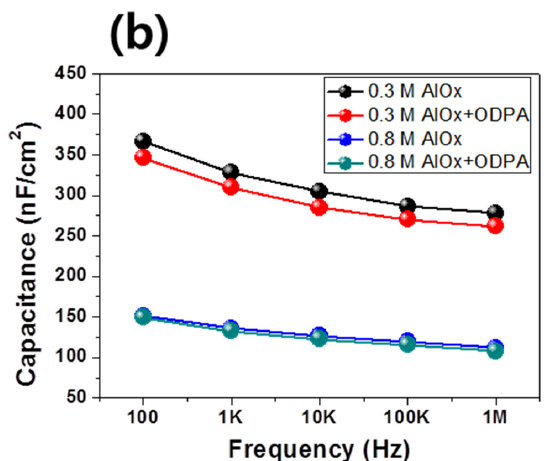
Figure 2. ( a ) Schematic illustration of metal–insulator–metal device structure and ( b ) capacitance vs.